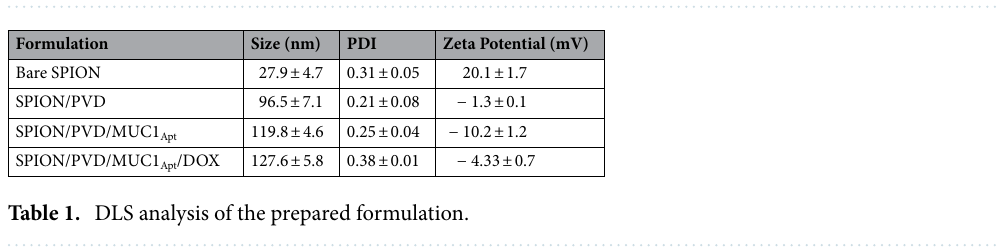
Figure 3. ( a ) Size distribution of the bare SPION and SPION/PVD conjugates, ( b ) UV absorption spectroscopy, ( c ) Fluorescence emission at excitation 400 nm, ( d ) EDX patterns, ( e ) VSM magnetization curves of SPION versus SPION/PVD and the directed movement under an external magnetic field, and ( f ) comparison between the TGA profiles of SPION and SPION/PVD.